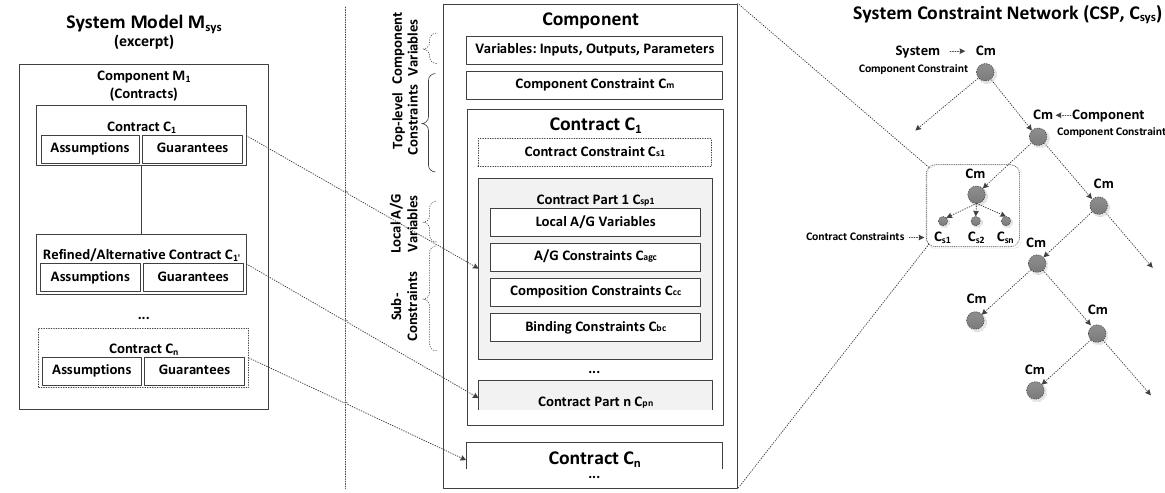
Fig. 5: Representation of a component in CSP: an exemplary component with three contracts (left) and an excerpt of the mapping of contracts to constraints and variables